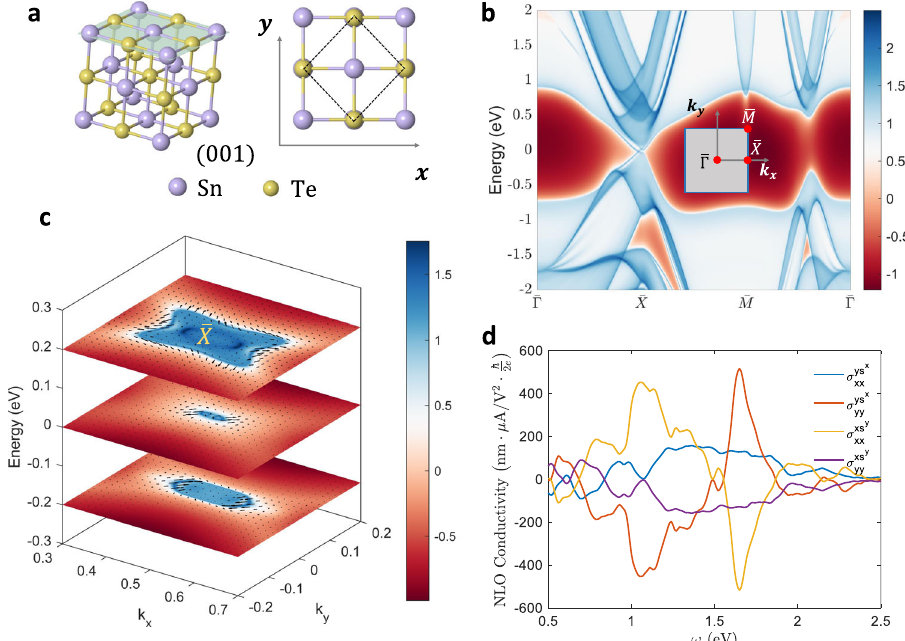
Fig. 4 NLO spin current on the (0 0 1) surface of SnTe. a The atomic structure of SnTe. In the left panel the {0 0 1} face is painted in light green, which possesses double mirror symmetries M x and M y . The dashed box in the right panel indicates the primitive cell on the surface. b The surface spectrum function A ð k ; ω Þ on high-symmetry lines in the BZ. The gapless surface states can be observed. c The surface spectrum function A ð k ; ω Þ over the BZ for selected ω ¼ (cid:3) 0 : 2 ; 0 ; and 0 : 2eV. k x and k y are in the unit of reciprocal lattices. The surface spin textures are indicated by the black arrows. Color scheme (red to blue) in ( b , c ) represents surface state contribution. The color bars are in logarithmic scale, and the energy is offset to the valence band maximum. d The NLO spin current conductivity with x and y spin polarizations. Note that all charge and spin- z current components are vanishing due to M x and M y .